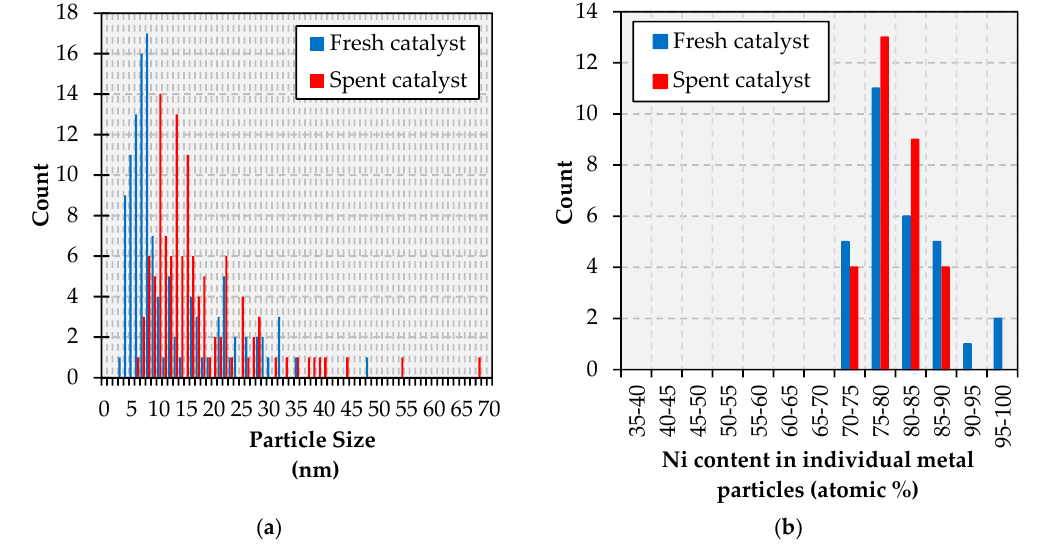
Figure 7. Particle size distribution ( a ) and metallic composition ( b ) histograms for the Ni-Fe catalyst.